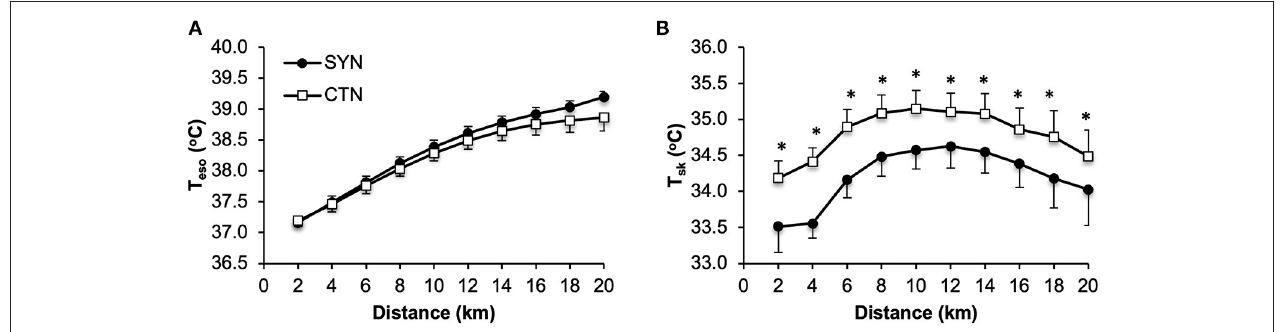
FIGURE 3 | Effect of wearing athletic clothing made of synthetic fabrics (SYN, 60% polyester: 40% nylon) and 100% cotton fabric (CTN) on (A) esophageal temperature (Teso) and (B) whole body mean skin temperature ( Tsk ) during a 20-km cycling time trial in endurance-trained adults ( n = 15). Values are means ± SE. * p < 0.05 vs.